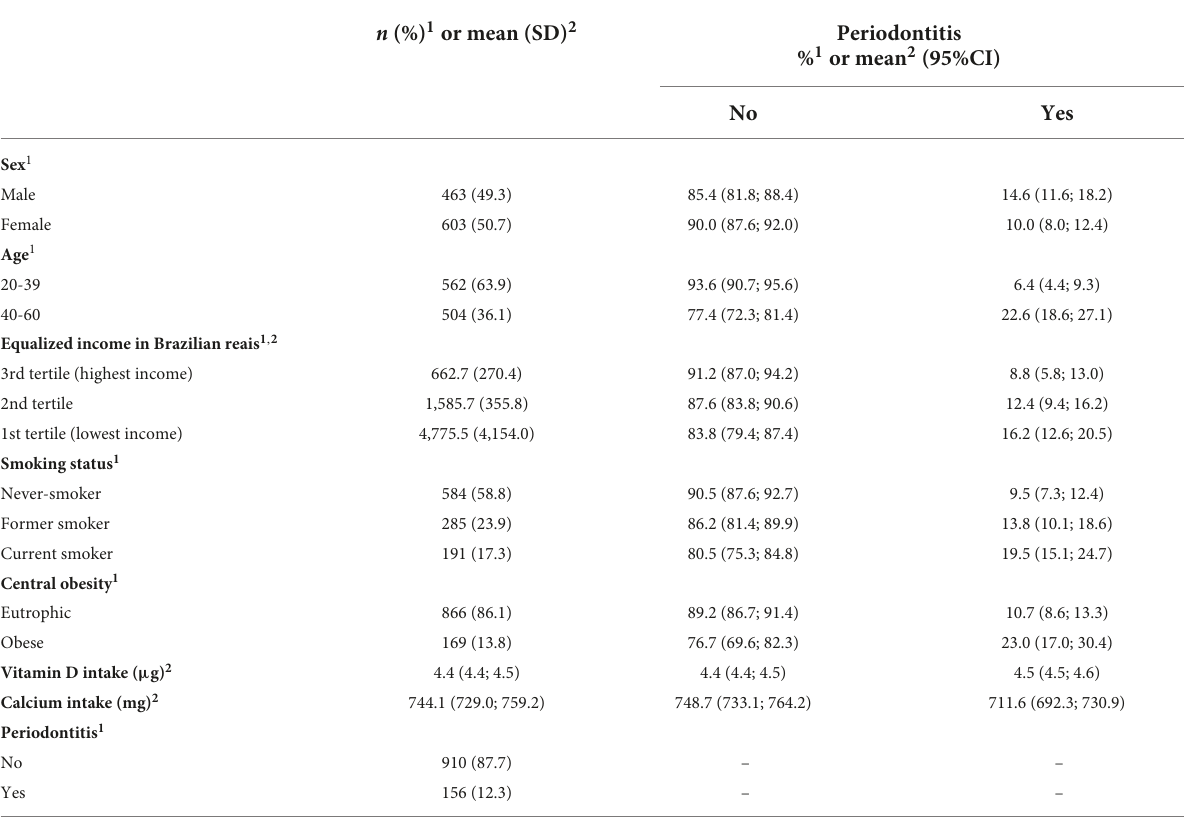
TABLE 1 Sample characteristics and distribution according to